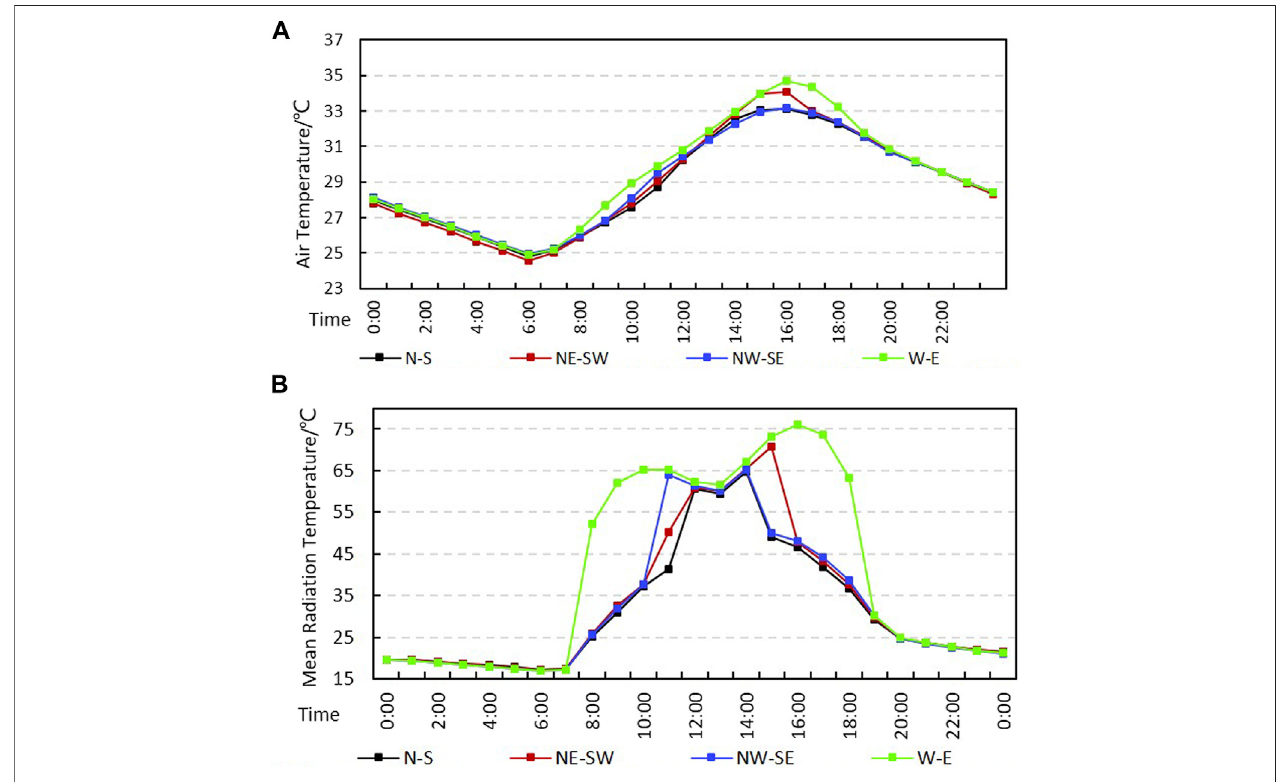
FIGURE 8 | Pro fi les of meteorological parameters in canyons with different orientations-air temperature (A) and mean radiation temperature (B) .